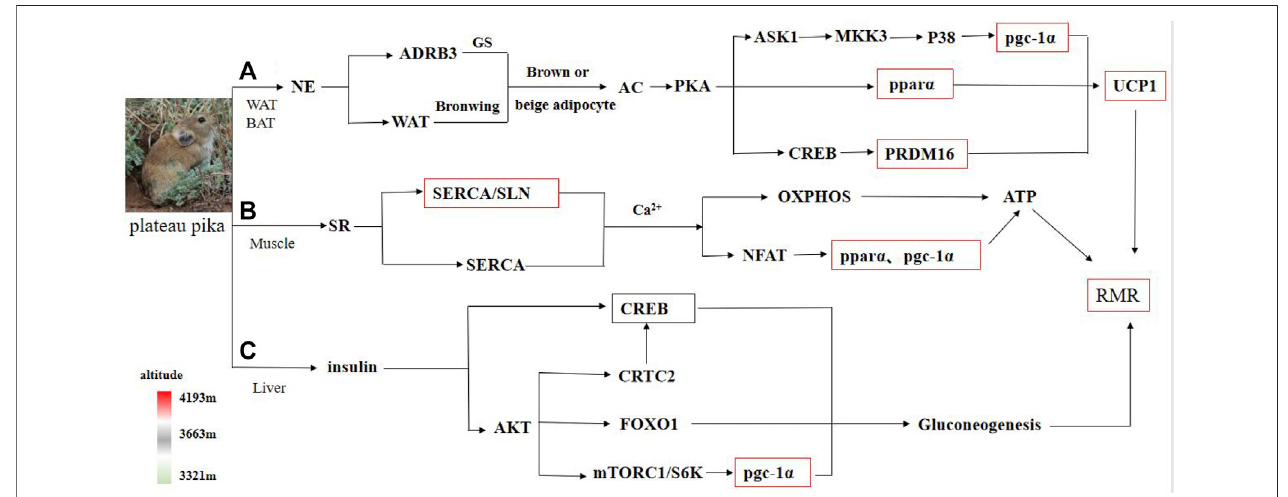
FIGURE 3 | Schematic of energy metabolism in various tissues of plateau pika. Note: The red box represents signi fi cant change in gene expression, whereas the green box represents no signi fi cant change in gene expression among regions with different altitudes. (A – C) represent the metabolic process of adipose tissue, muscle tissue and liver tissue,